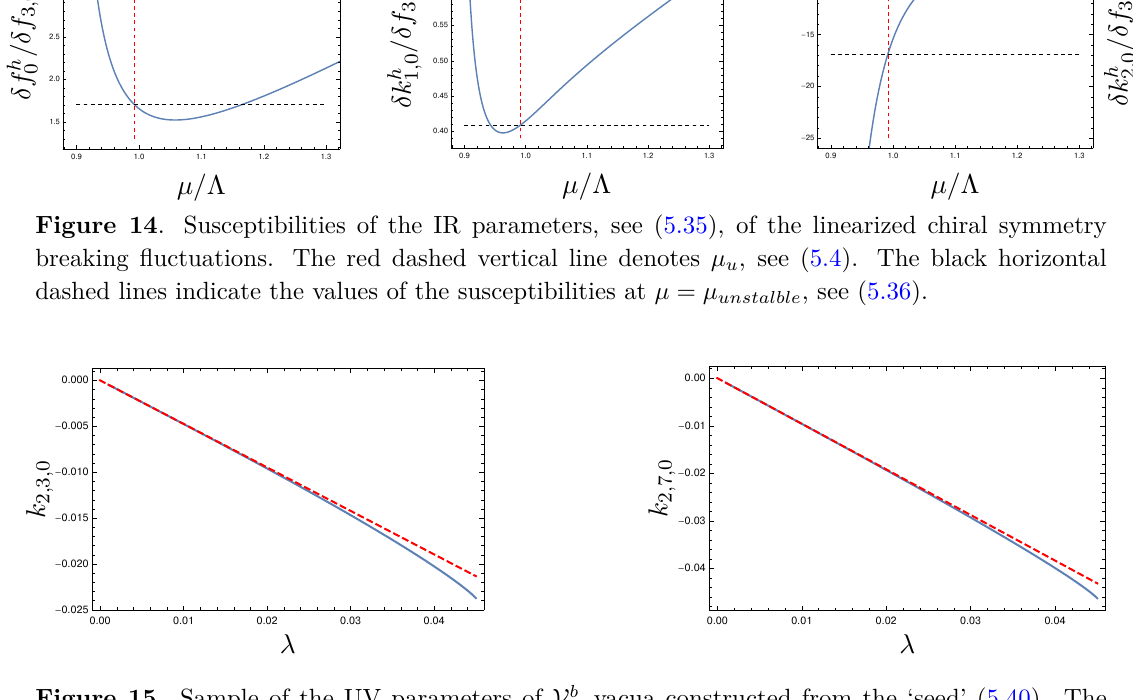
Figure 15 . Sample of the UV parameters of linearized approximations in λ are represented by dashed red